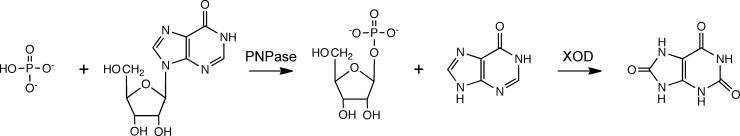
Reaction steps leading to the production of uric acid at the expense of phosphate and inosine.